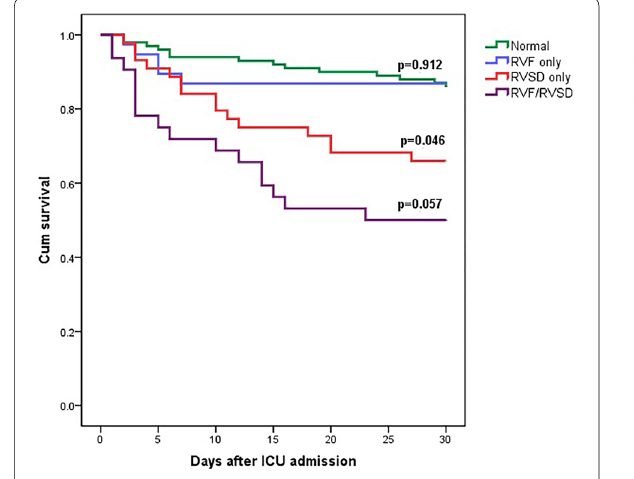
Fig. 4 The Kaplan–Meier curves for estimated survival analysis. The RVF/RVSD group had the highest mortality (RVF/RVSD vs. RVSD only, log-rank:3.662, p 0.057; RVF/RVSD vs. RVF only, log-rank:12.613, = p < 0.001; RVF/RVSD vs. normal, log-rank:25.208, p < 0.001); The RVSD only group had higher mortality than the RVF only and normal groups (RVSD only vs. RVF only, log-rank:3.995, p 0.046; RVSD = only vs. normal, log-rank: 7.376, p 0.007); No difference was found = between the RVF only group and the normal group (RVF only vs. Normal, log-rank: 0.012, p 0.912). RVF only patients with RV failure = but without RV systolic dysfunction, RVSD only patients with RVSD but without RV failure, RVF/RVSD patients with combined RVF–RVSD